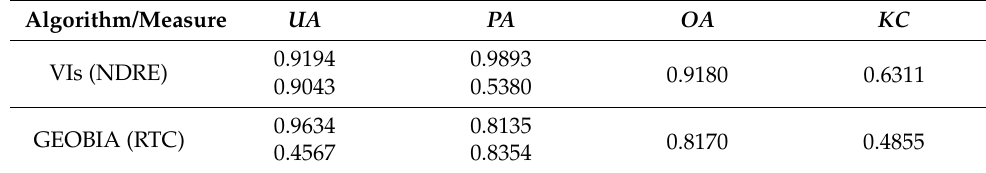
Table 4. Accuracy assessment results for 1000 points